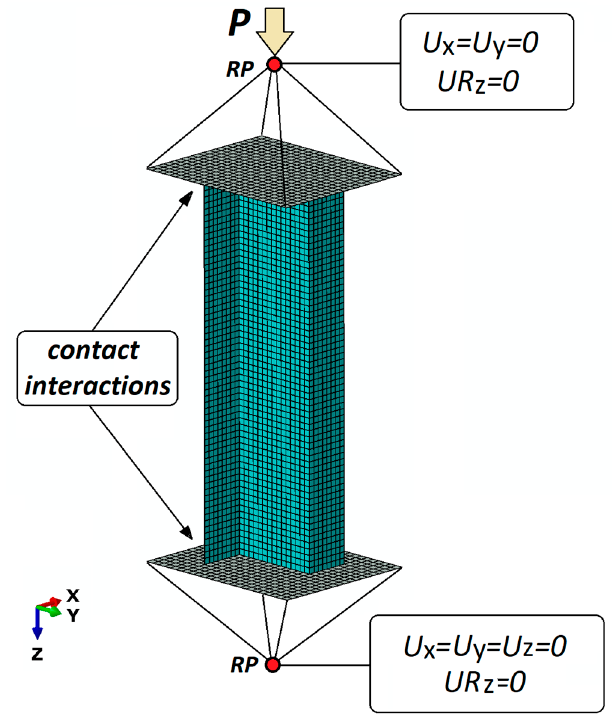
Figure 4. Numerical model of the analyzed structure.